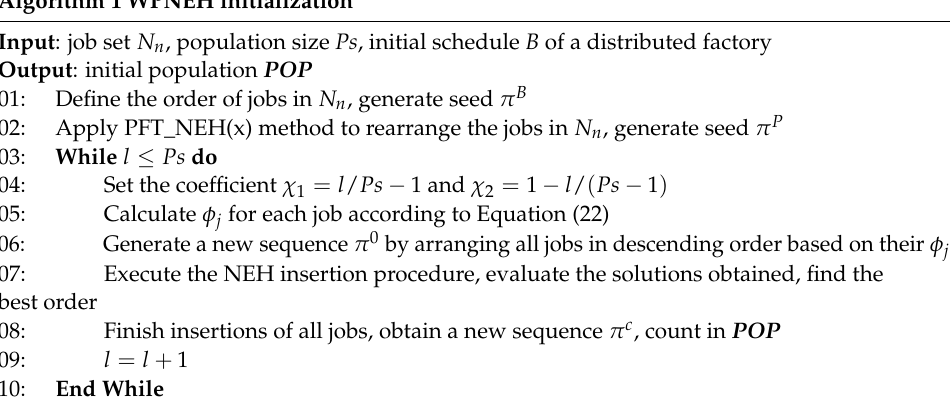
Algorithm 1 WPNEH